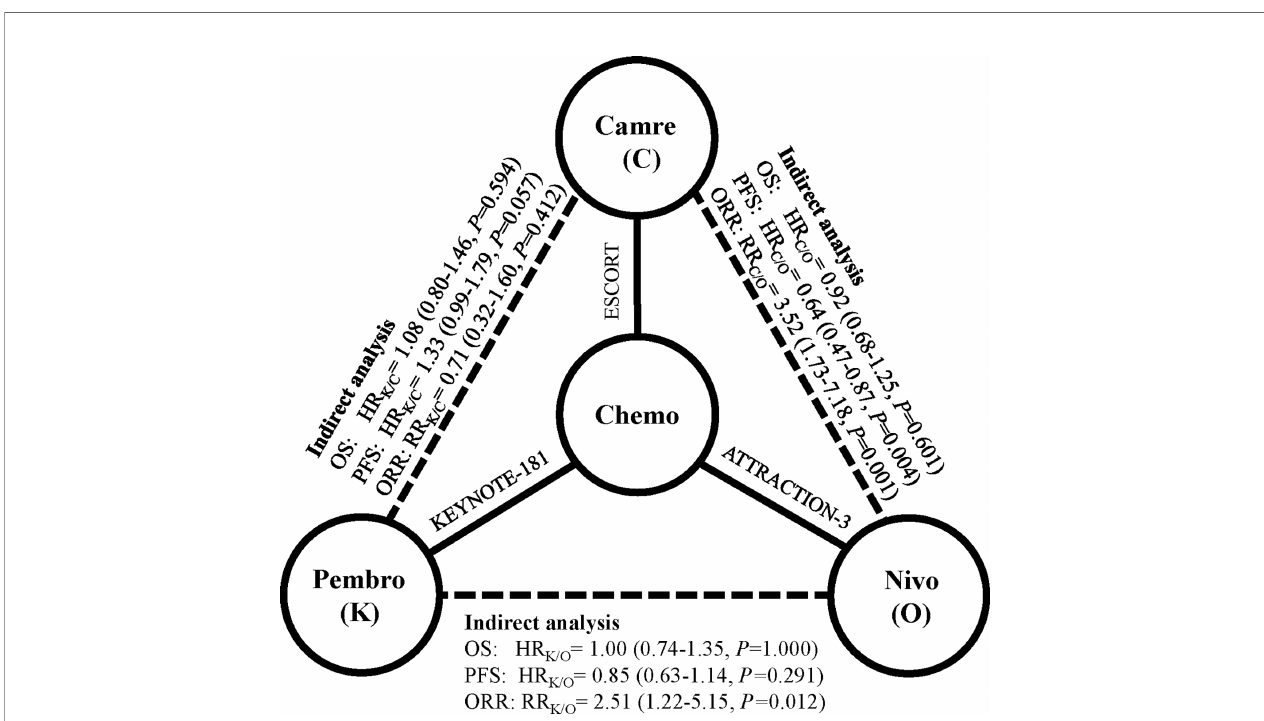
FIGURE 1 | Indirect comparison among pembrolizumab, nivolumab, and camrelizumab in terms of overall survival (OS), progression-free survival (PFS), and objective response rate (ORR). Solid lines represent the existence of direct comparisons between treatment regimens, and dashed line represents the indirect comparison among the three PD-1 inhibitors. All statistical tests were two sided. Abbreviations: Pembro, pembrolizumab; Nivo, nivolumab; Cam, camrelizumab; PD-1, programmed cell death 1; HR, hazard ratio; RR, risk ratio.